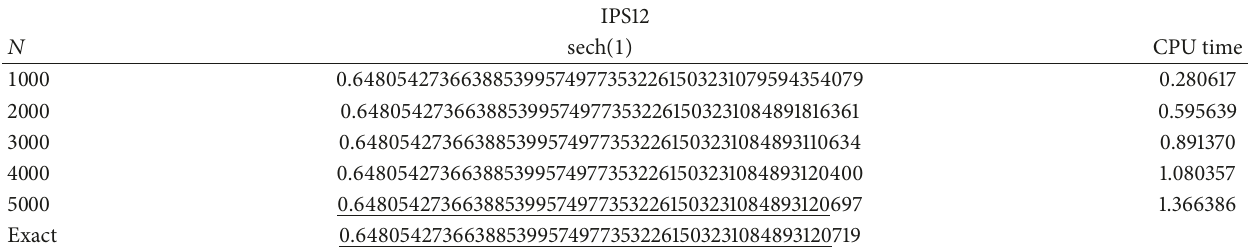
Table 3: IPS12 sech (𝑥) solution of the NLSE, (29), computed at 𝑥 = 1 . IPS12